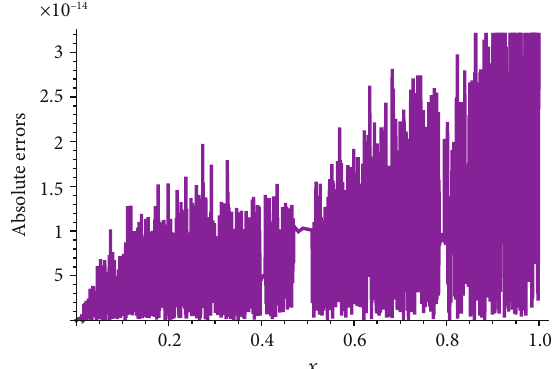
Figure 6: Absolute errors of u Example 1.